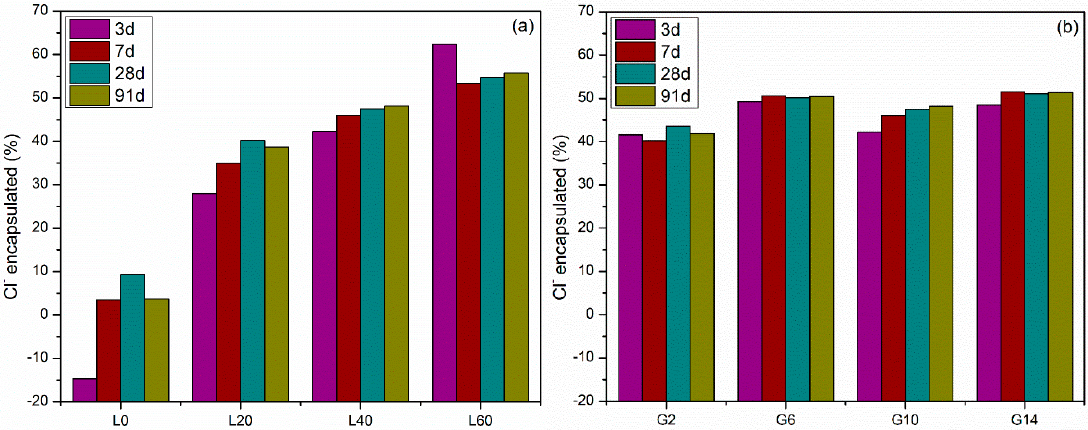
Figure 9. Chloride encapsulation at 3, 7, 28, and 91 days for ( a ) group L mixtures and ( b ) group G mixtures.